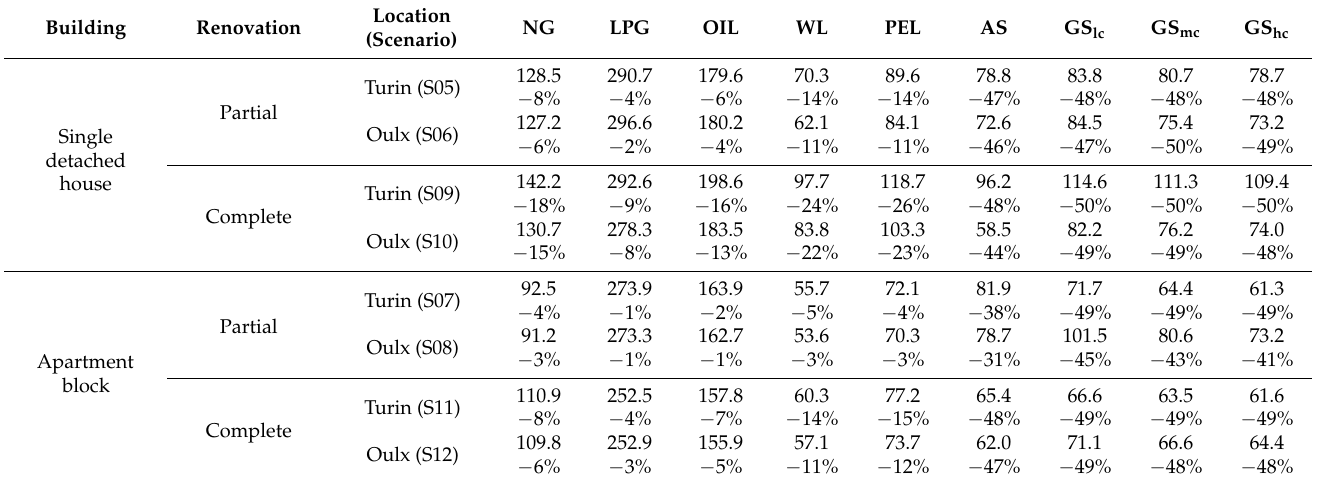
Table 6. LCOH values (EUR/MWh) for the different heating-only systems. The LCOH with the application of incentives is reported in the first row of each case, whereas the relative reduction with respect to the scenario without incentives is in the second row. Legend: NG = natural gas condensing boiler, LPG = LPG condensing boiler, OIL = diesel oil condensing boiler, WL = wood logs boiler, PEL = pellet boiler, AS = air-source heat pump, GS = geothermal heat pump (subscripts stand for low, medium and high conductivity,